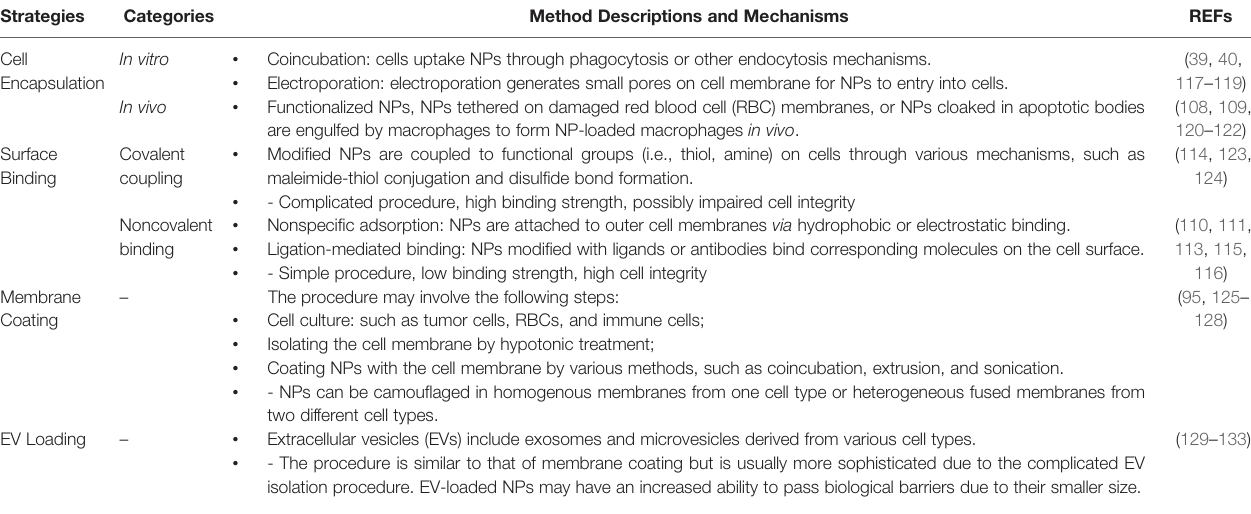
TABLE 1 | NP loading in macrophage-based drug